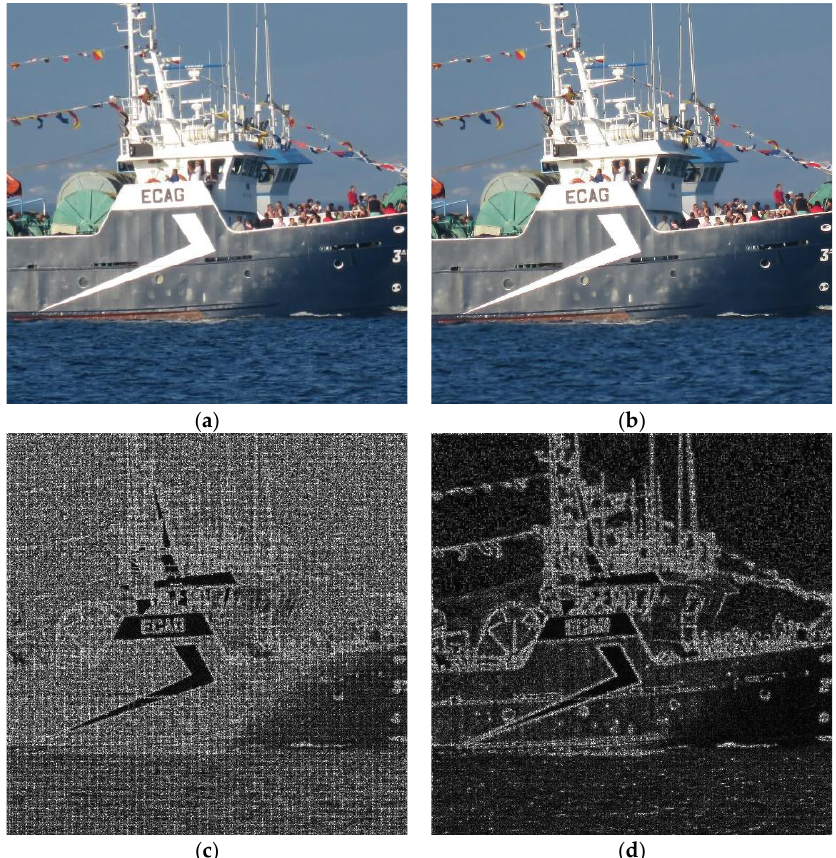
Figure 4. ( a ) Original image; ( b ) image processed using method I ; ( c , d ) noise patterns (PRNU) obtained from each of the above images.